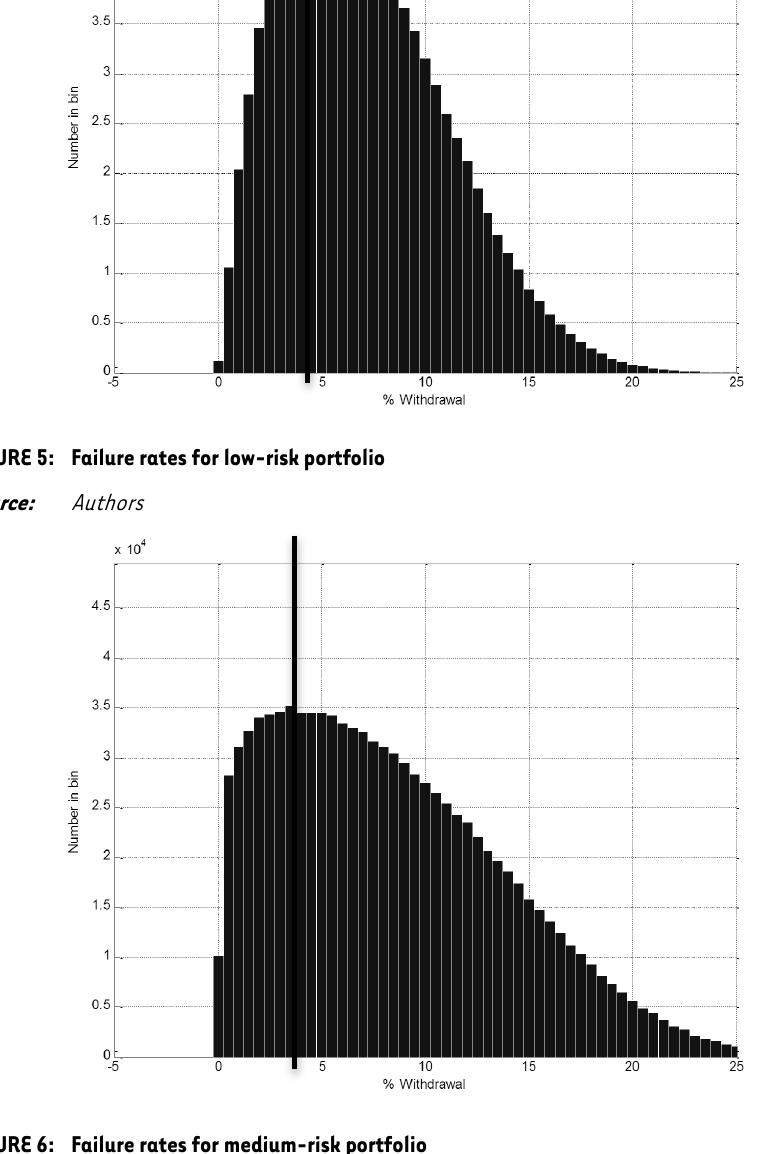
FIGURE 6: Failure rates for medium-risk portfolio